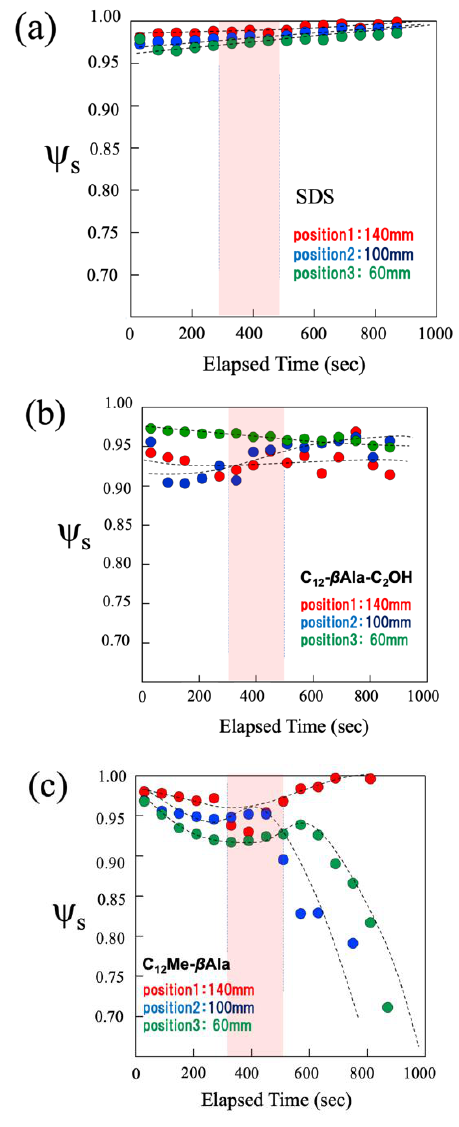
Figure 19. Volume fraction of surfactant in foam film ( ψ s ) at different heights of 140 mm (red), 100 mm (blue), and 60 mm (green), obtained for ( a ) SDS, ( b ) C 12 – EtOH – β Ala, and ( c ) C 12 – Me – β Ala. The time domain at 300 – 480 s is indicated in red. Broken lines are guides for the eye.